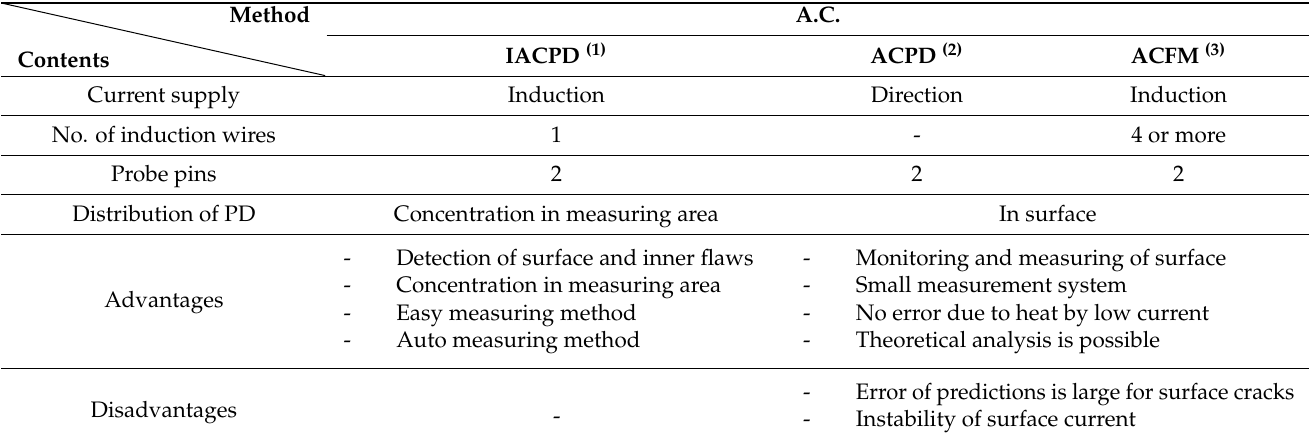
Table 1. Comparison of potential drop